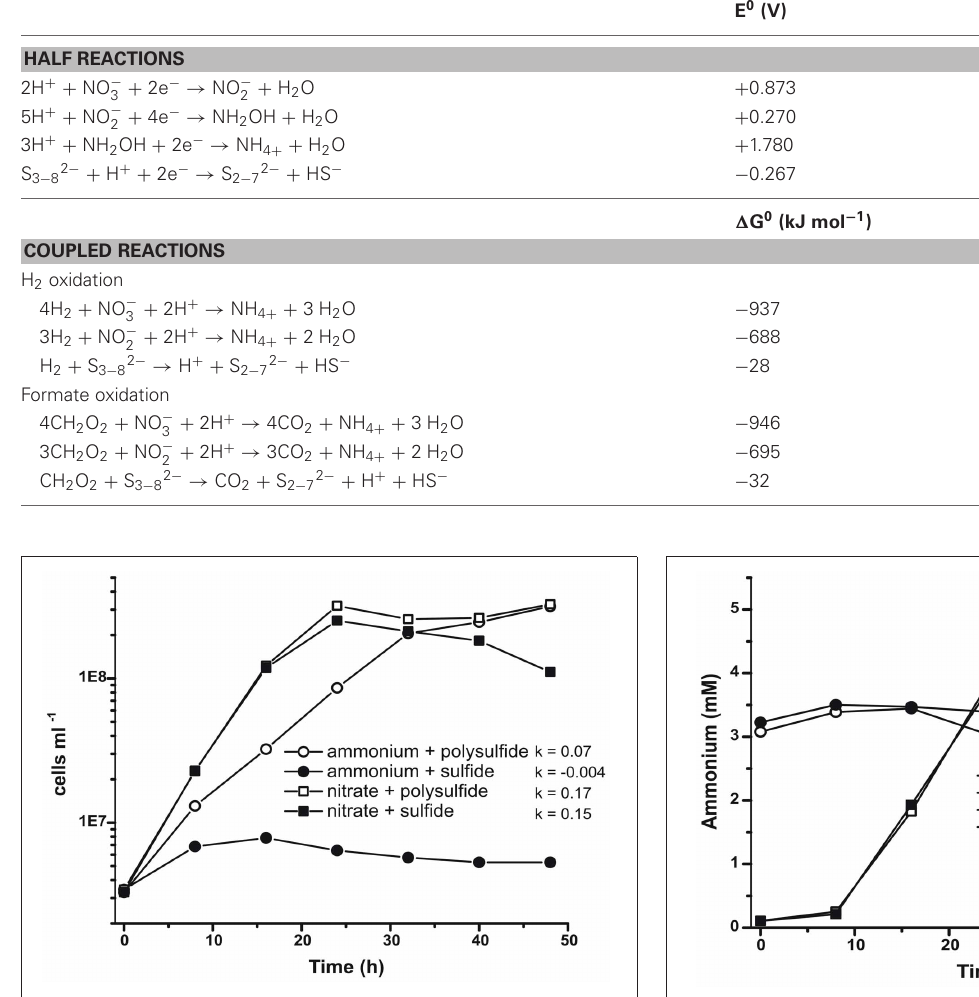
FIGURE 3 | Ammonium concentrations measured in cultures of N. profundicola -containing the indicated electron acceptors, nitrogen compounds, and sulfur sources. Each point is the average of 2 or 3 independent biological